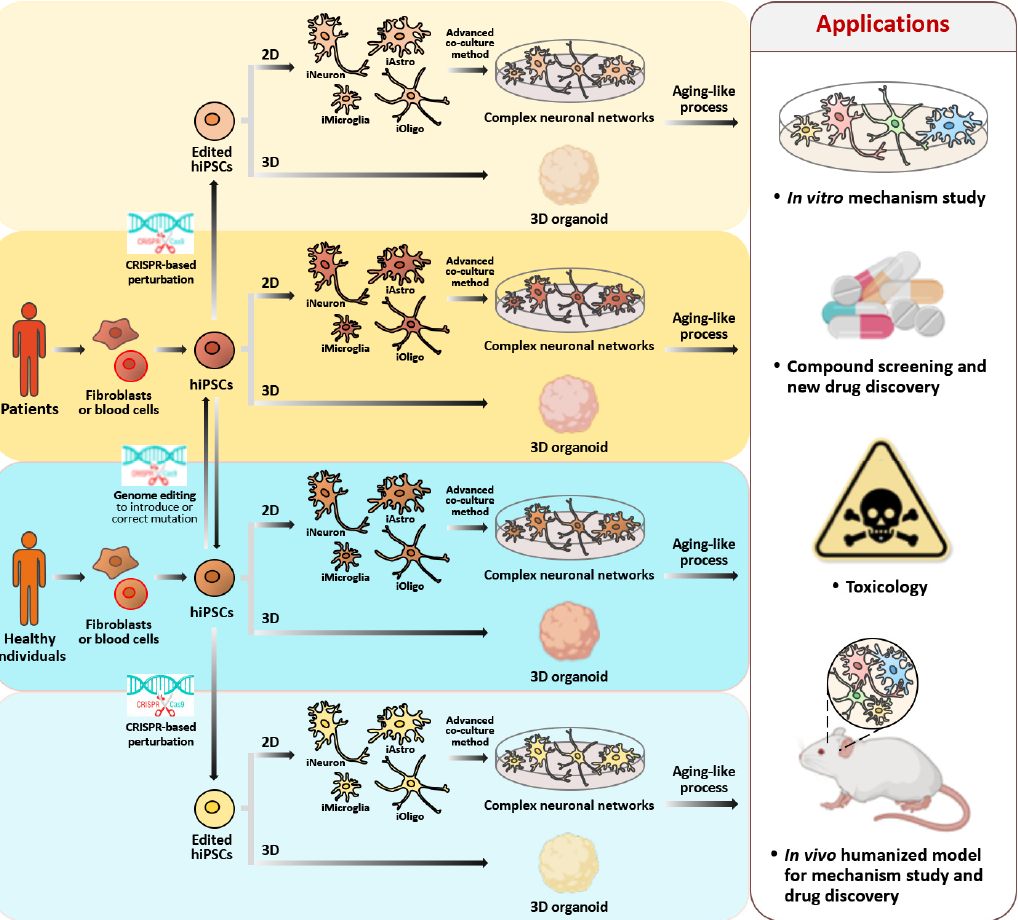
Figure 4. Schematic representation of the workflow of hiPSC generation, genome editing, and neuronal differentiation from an individual’s somatic cells, and their major applications in the area of human healthy aging. A healthy person’s or patient’s somatic cells are reprogrammed into a pluripotent stage. To generate isogenic control iPSCs for the